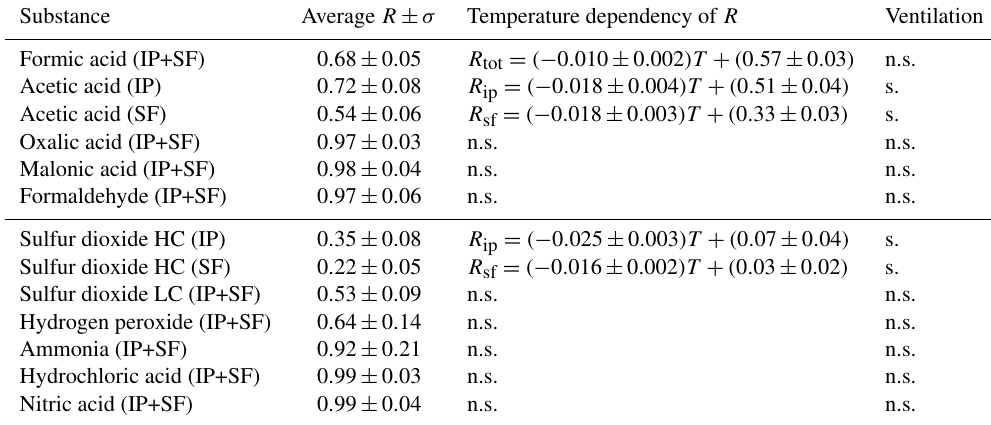
Table 3. Retention coefficients of the measured substances, their temperature dependencies, and the effect of ventilation. s.: significant; n.s.: not significant; IP: ice particles; and SF: snowflakes. Organic species: present study. Inorganic species: adopted from von Blohn et al. (2011) and von Blohn et al. (2013). HC: high concentration. LC: low